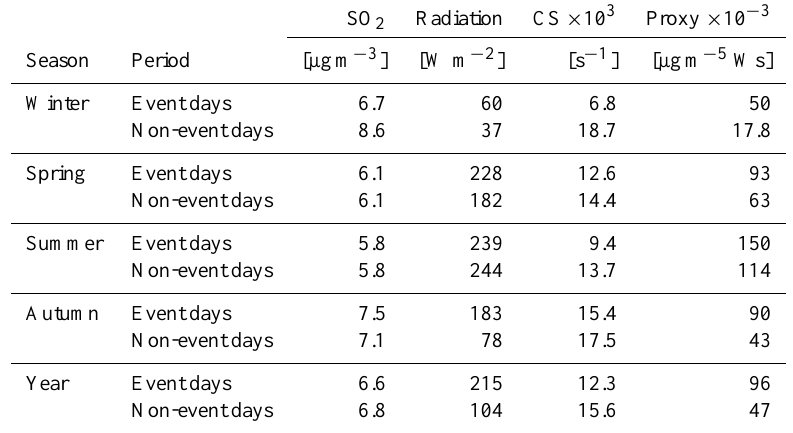
Table 2. Median SO 2 concentration, solar radiation, condensation sink (CS) and gas-phase H 2 SO 4 proxy averaged separately for the days with new particle formation event and without new particle formation event over the four seasons and year.